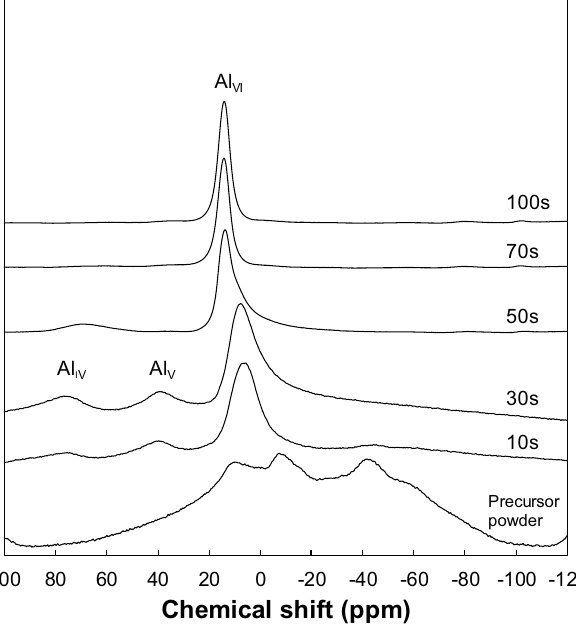
Figure 3. A series of 27 Al MAS NMR spectra for the precursor powder calcined at 1200 °C. For comparison, the result for the precursor powder is also shown in the